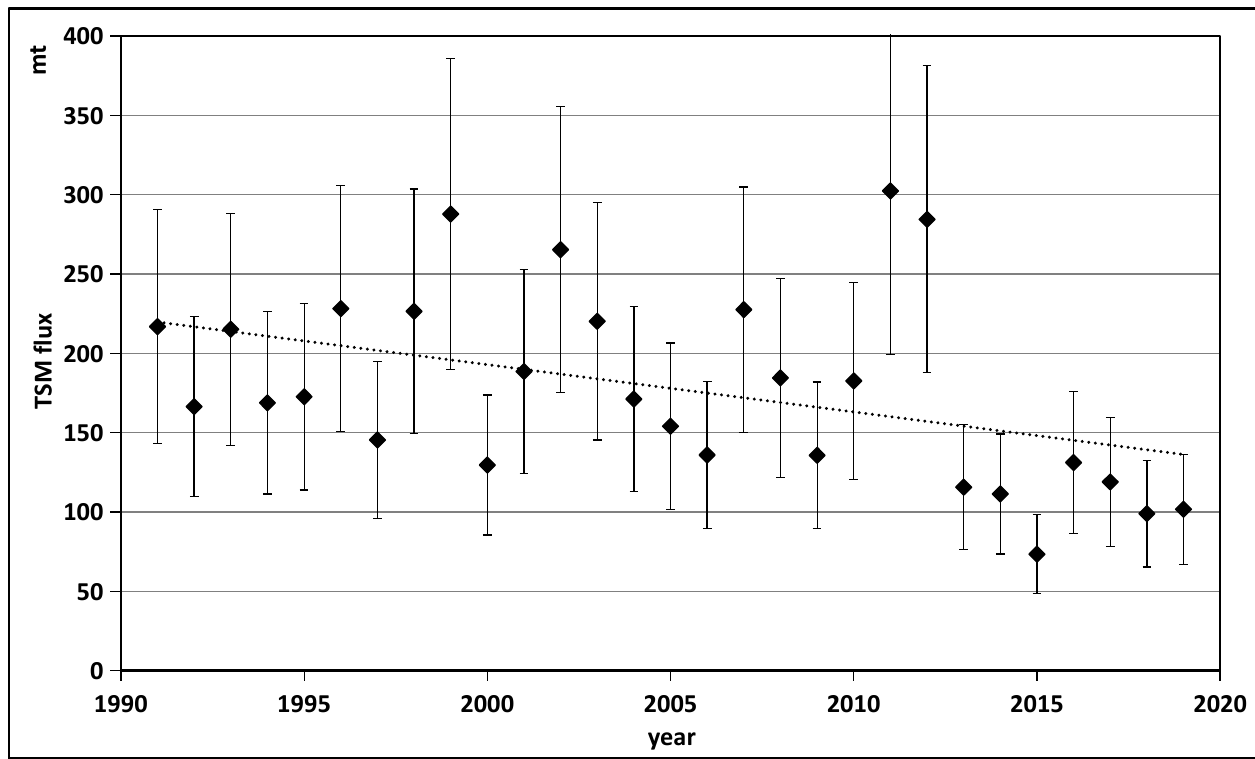
Figure 8. Changes in F TSM in the Padma River in the period 1991–2019. The dotted line is the linear regression of F TSM .